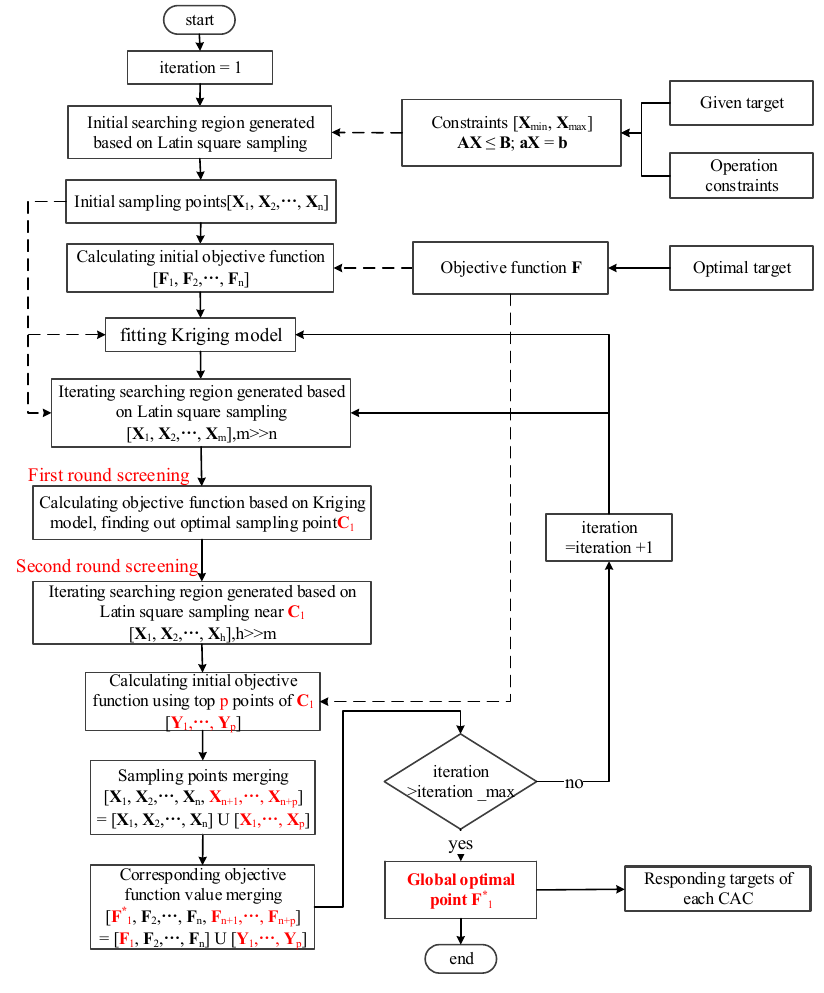
Figure 9. SEUMRE algorithm flow chart.